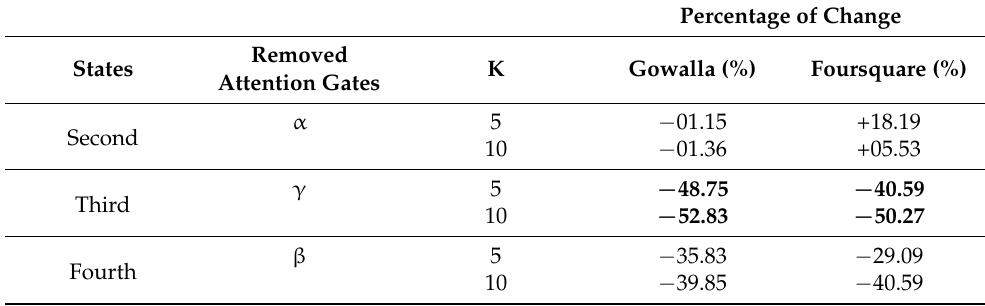
Table 5. The performance of each CI attention gate.